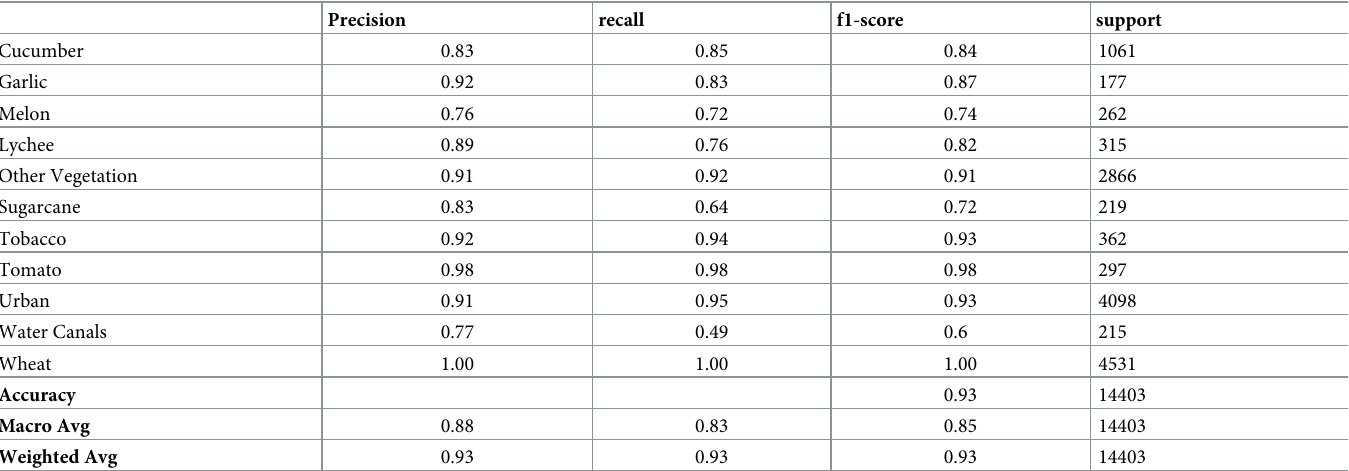
Table 3. Classification report only Sentinel